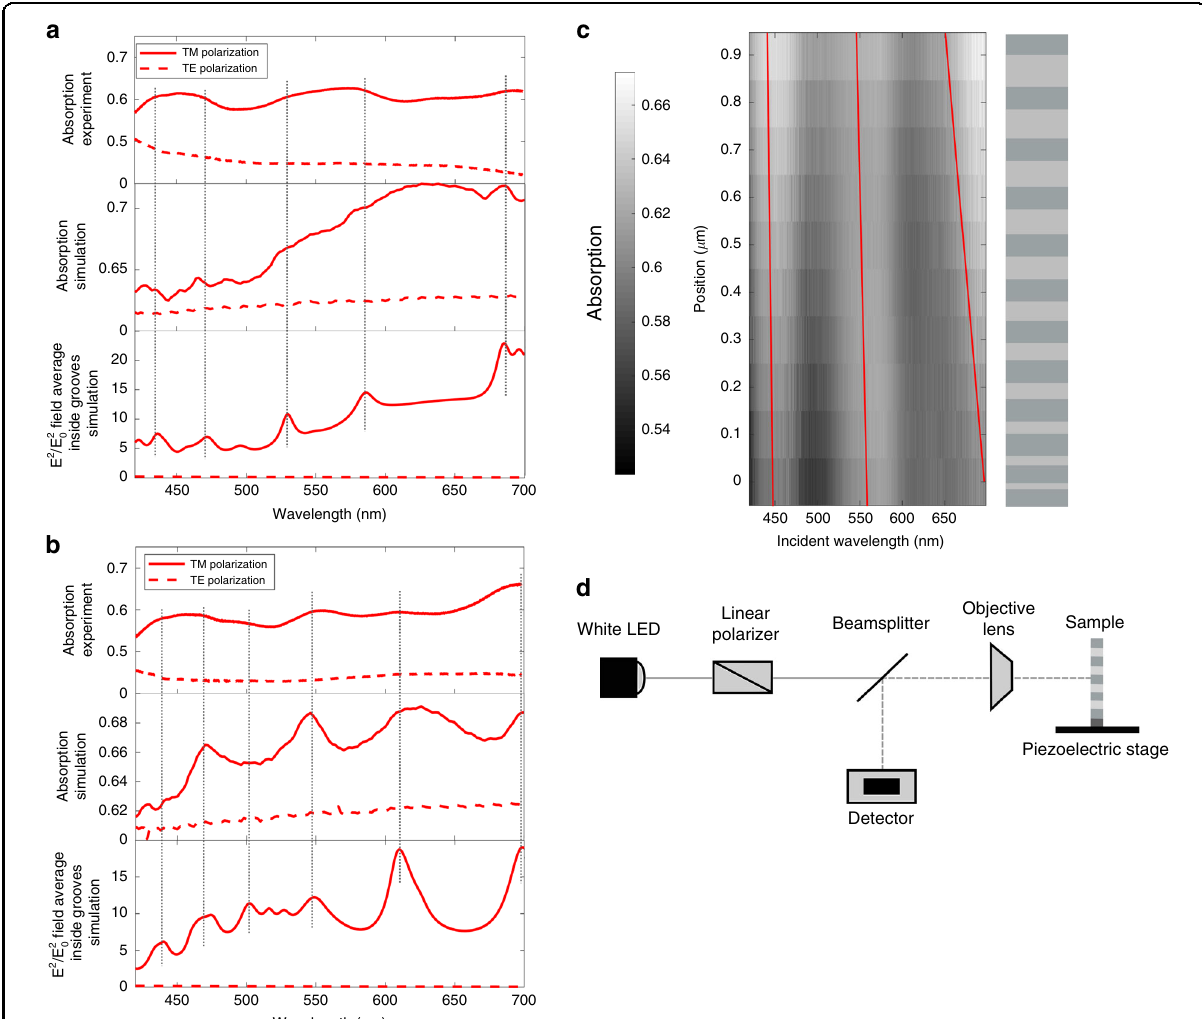
Fig. 5 Optical response of graded arrays in the near and far- fi eld. a , b Experimental and simulated 1 − R absorption data and simulated | E | 2 /| E o | 2 electric fi eld data for both TM and TE polarisations for a a width-graded array and b a bigradient array. c Experimental 1 − R absorption data as a function of array position under TM polarisation for a width-graded array. The schematic illustrates the change in position across the array while the red lines visualise the shifting absorption bands. d Schematic illustration of the hyperspectral microscopy